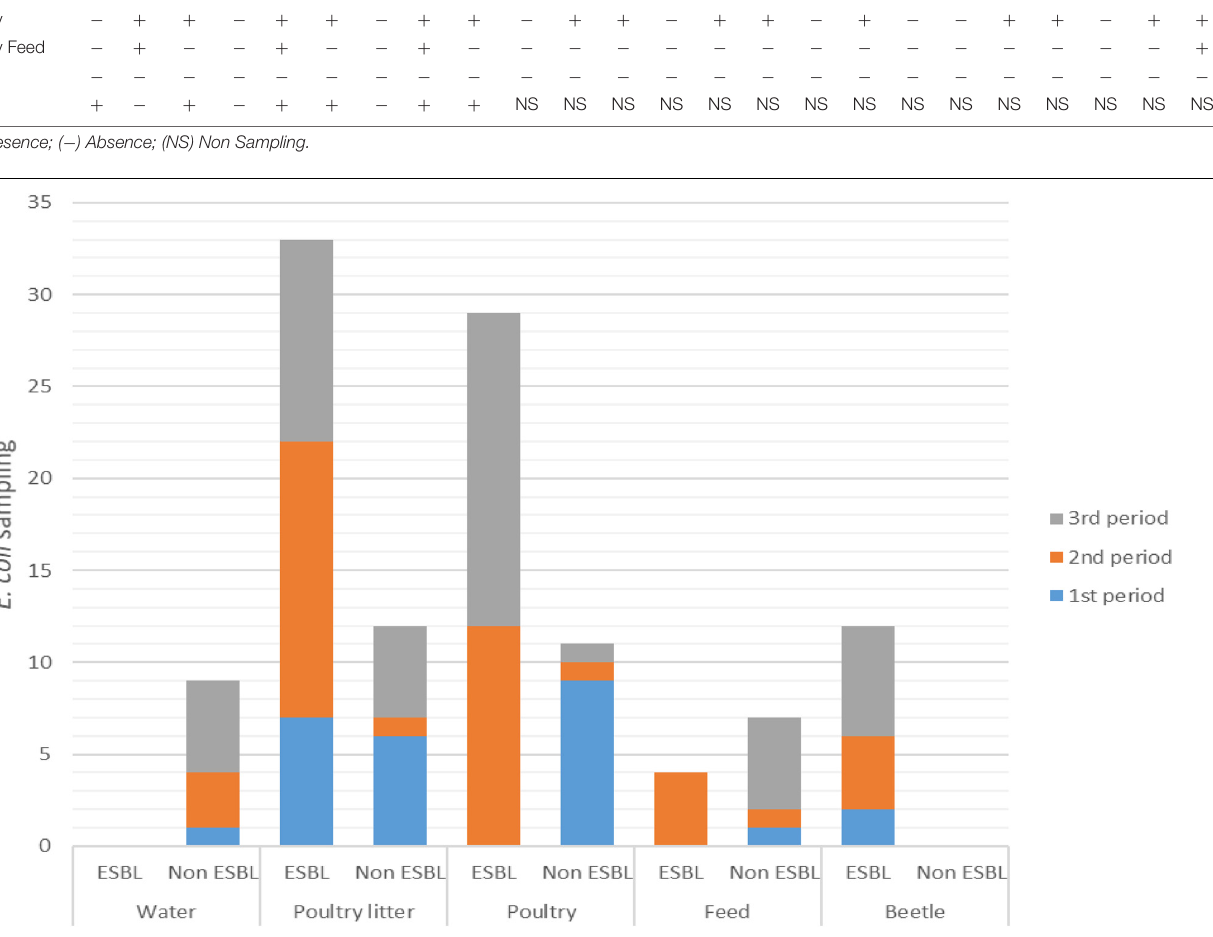
FIGURE 1 | Distribution of ESBL-producing and non-ESBL-producing E. coli during the sampling